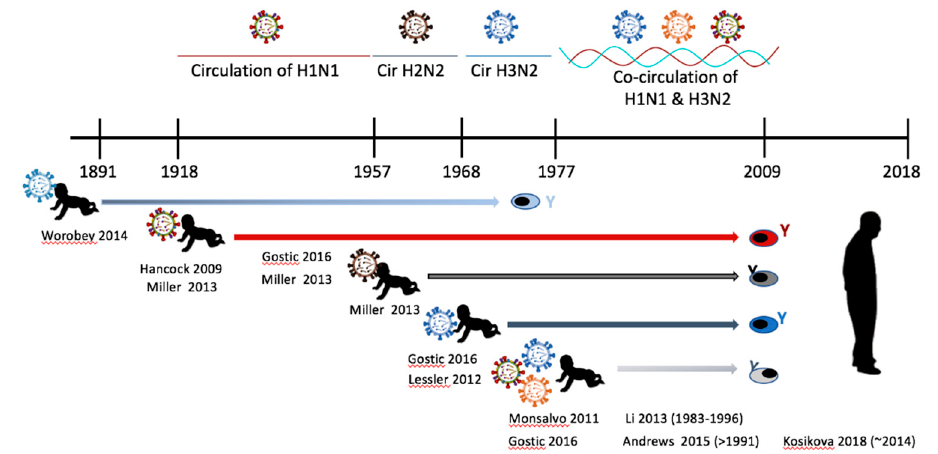
Figure 4. Influenza immune imprinting and the history of circulating influenza viruses. The timeline illustrates the relationship between virus circulation and influenza virus immune imprinting at infancy. Several published studies have shown that antibodies reactive toward the imprinting virus can last throughout the host’s lifetime. Human studies investigating imprinting serology, epidemiology, or cell reactivity are noted in the figure for the time period of imprinting. The author’s last name and publication date are given. The date in parentheses refers to study subjects’ date of birth if it is not easily deduced from the timeline.